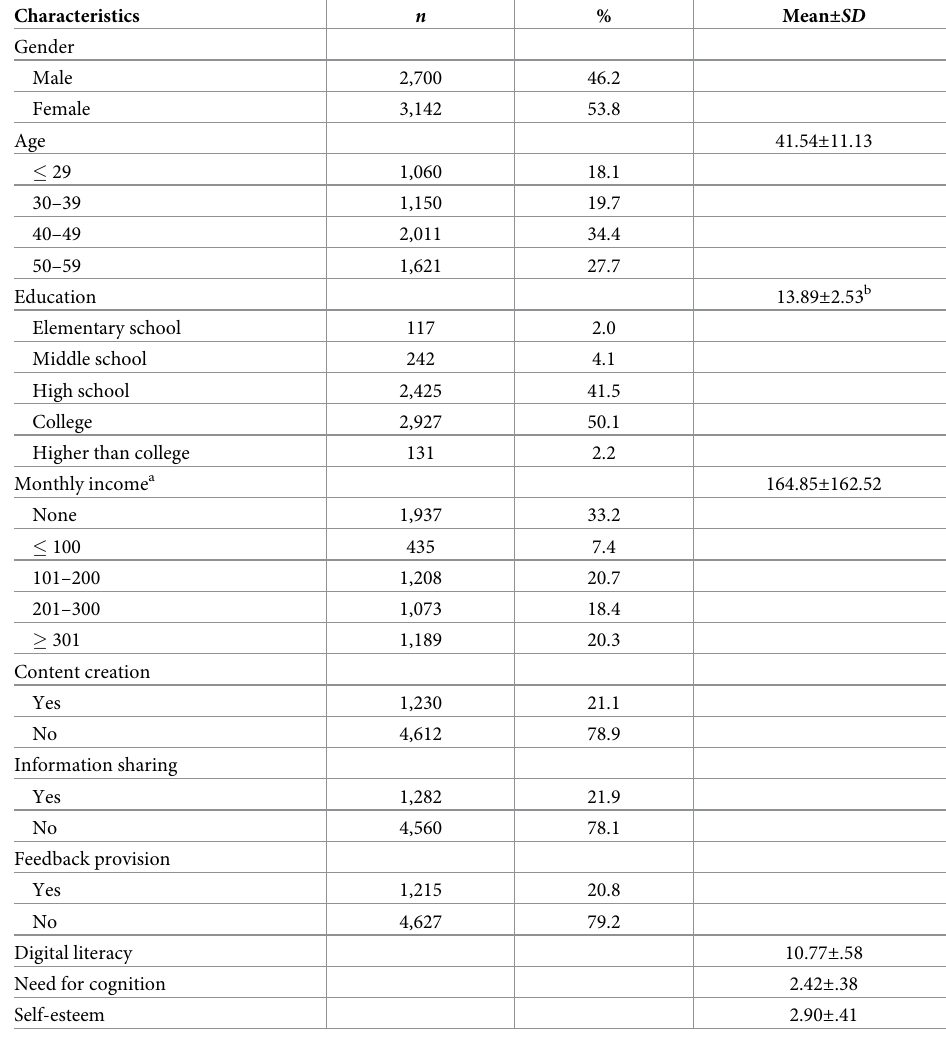
Table 1. Participants’ characteristics ( n = 5,842).